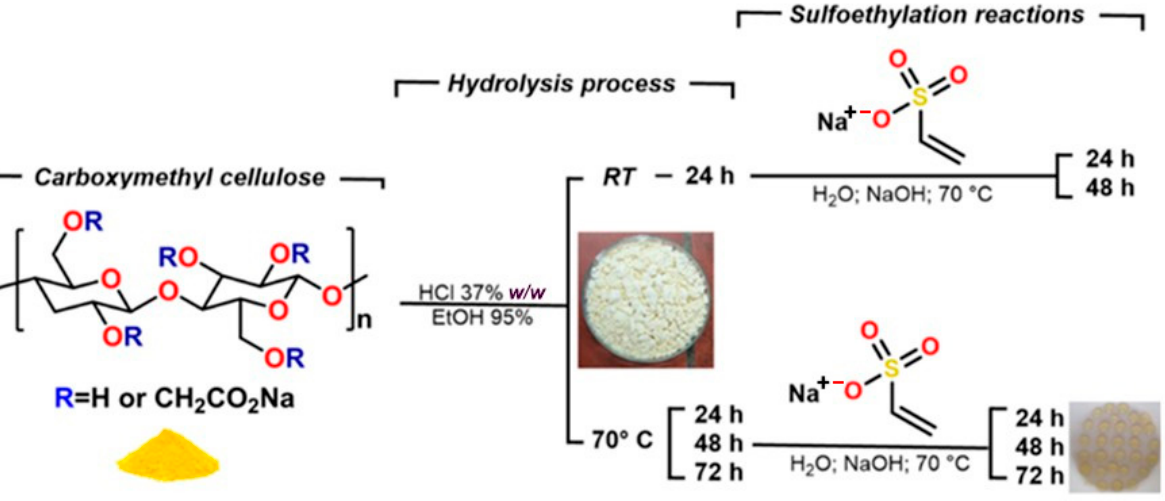
Figure 2. Overview of the synthesis workflow.